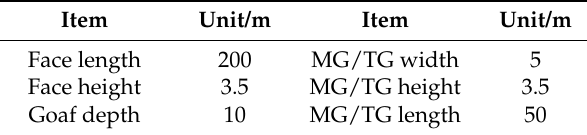
Table 2. The longwall model dimensions.